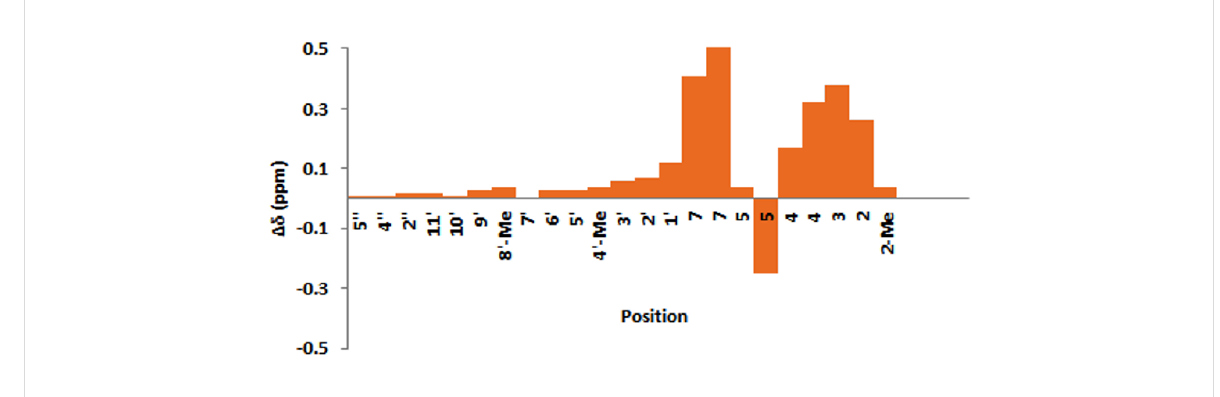
Figure 2: Δδ (ppm) of 1 H NMR chemical shifts in 1 . Δδ corresponds to the difference in chemical shift for natural and synthetic products ( Δδ = δ (syn- thetic) – δ (natural)).